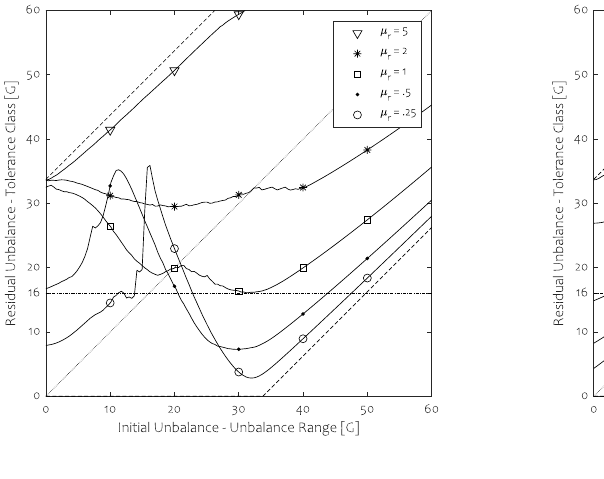
Figure 11. An increase of friction leads to a global deterioration of balancing capabilities for the STD and TSR technique. ( a ) STD, ( b ) TSR. Sweep-up and haziness of the balancing outcomes occur respectively for STD and TSR as stability is only guaranteed in a narrow upper part of the adopted speed profile for a low initial unbalance